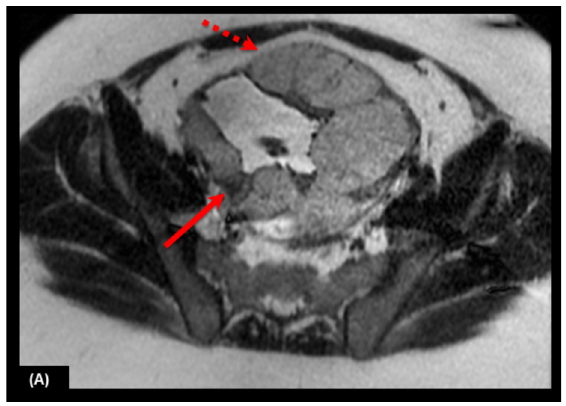
Fig. 4. 42-year-old woman at 35 weeks ' gestation and one previous C-section. (A) Axial T2 weighted images shows intraplacental T2 dark band (arrow) and placental bulges (dashed arrows).